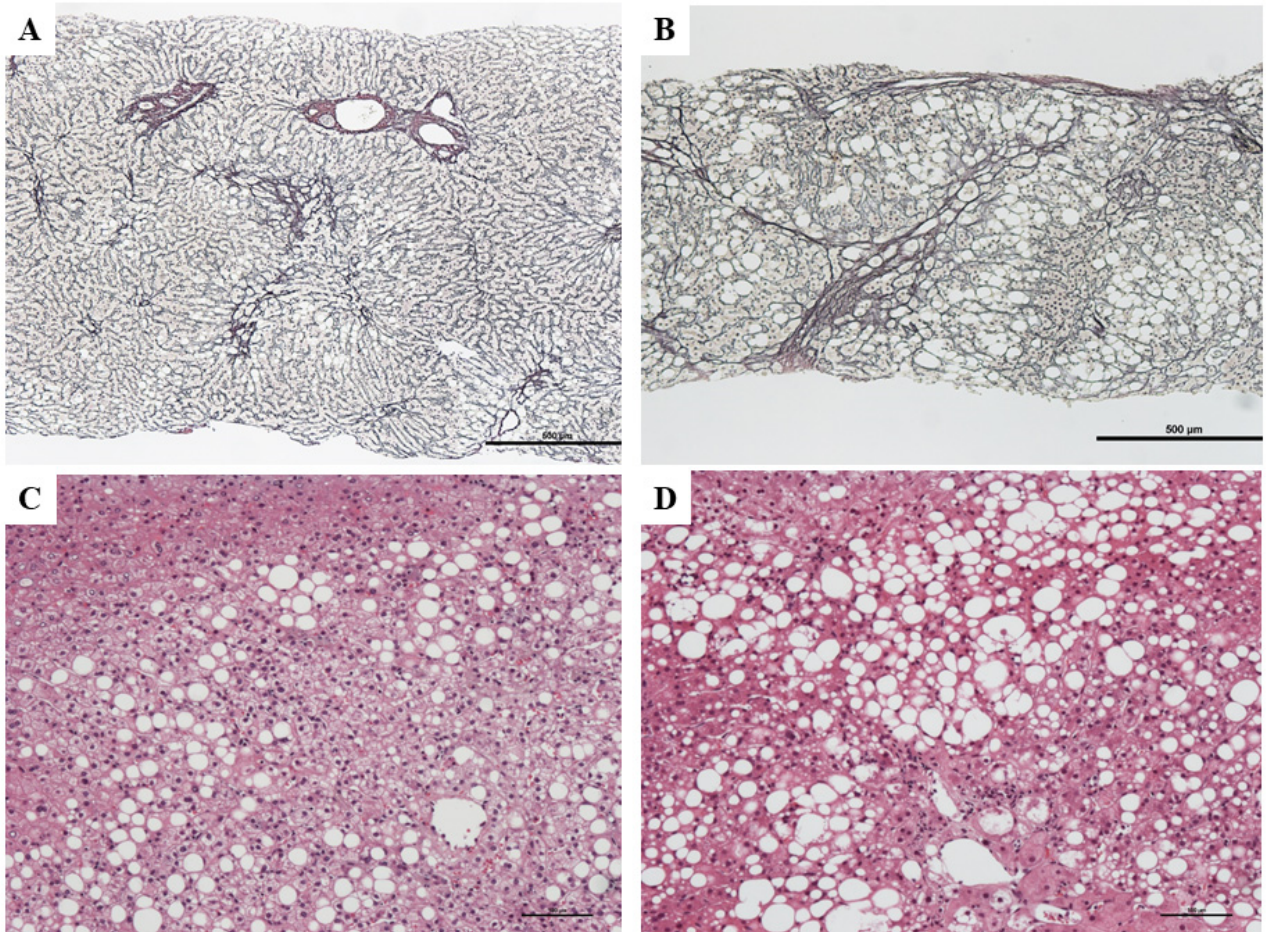
Figure 1. Histological findings of NAFLD. ( A ) Tissue sample with fibrosis stage 1b. ( B ) Tissue sample with fibrosis stage 3. ( C ) Tissue sample with NAS 2: steatosis, 1; lobular inflammation, 1; and ballooning degeneration, 2. ( D ) Tissue sample with NAS 6: steatosis, 2; lobular inflammation, 2; and ballooning degeneration,